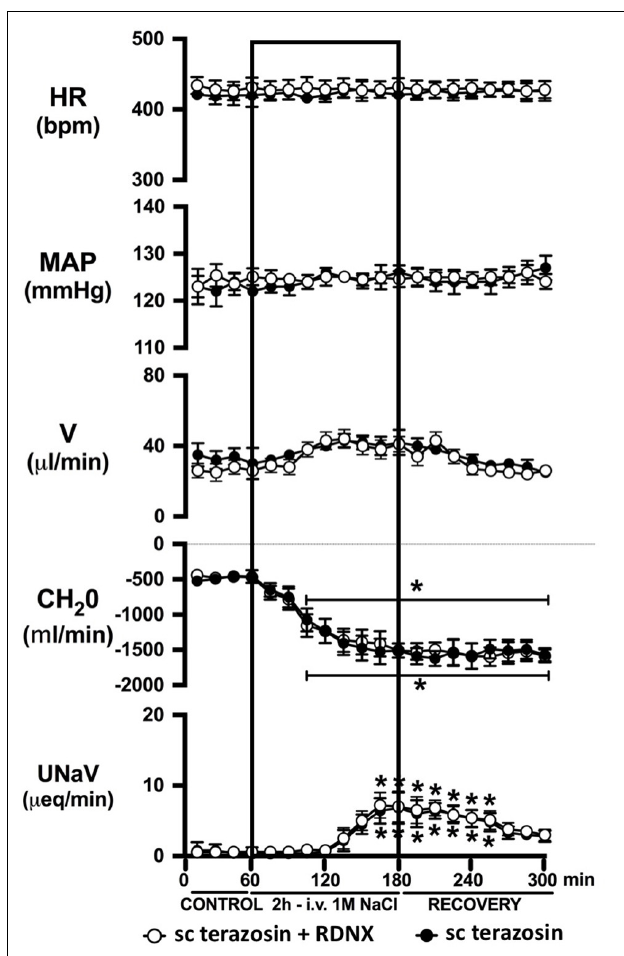
FIGURE 7 | Effect of acute RDNX in combination with chronic s.c. terazosin-mediated 1-adrenoceptor antagonism on the cardiovascular and renal responses to an acute 1M NaCl infusion Cardiovascular and renal responses during a 1-h control isotonic saline infusion (20 µ l/min), a 2-h 1M NaCl infusion (20 µ l/min) and a 2-h recovery period of isotonic saline infusion (20 µ l/min) in intact or acutely RDNX conscious male Sprague Dawley rats receiving a sc terazosin (10 mg/kg/day) infusion. HR = heart rate (bpm), MAP = mean arterial pressure (mmHg), V = urinary flow rate ( µ L/min), CH 2 O = free water clearance, UNaV = urinary sodium excretion ( µ eq/min). Data are presented as mean ± SEM, N = 6/group. * p < 0.05 vs. group baseline value in last 15-min of the control saline infusion. Please note the sc terazosin data in intact animals is transposed from Figure 6 for